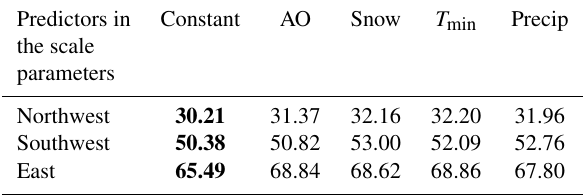
Table 7. Effective return periods of 10-, 50-, and 100-year events of the PDSI values, based on the best GPD models. (The actual PDSI values are negative ones of these values.) 10-year 50-year 100-year event event event Southwest Northwest Figure 9. The 95% confidence intervals of parameters, using other climate variables based on the normal approximation. Also numer- ical values are listed in Table